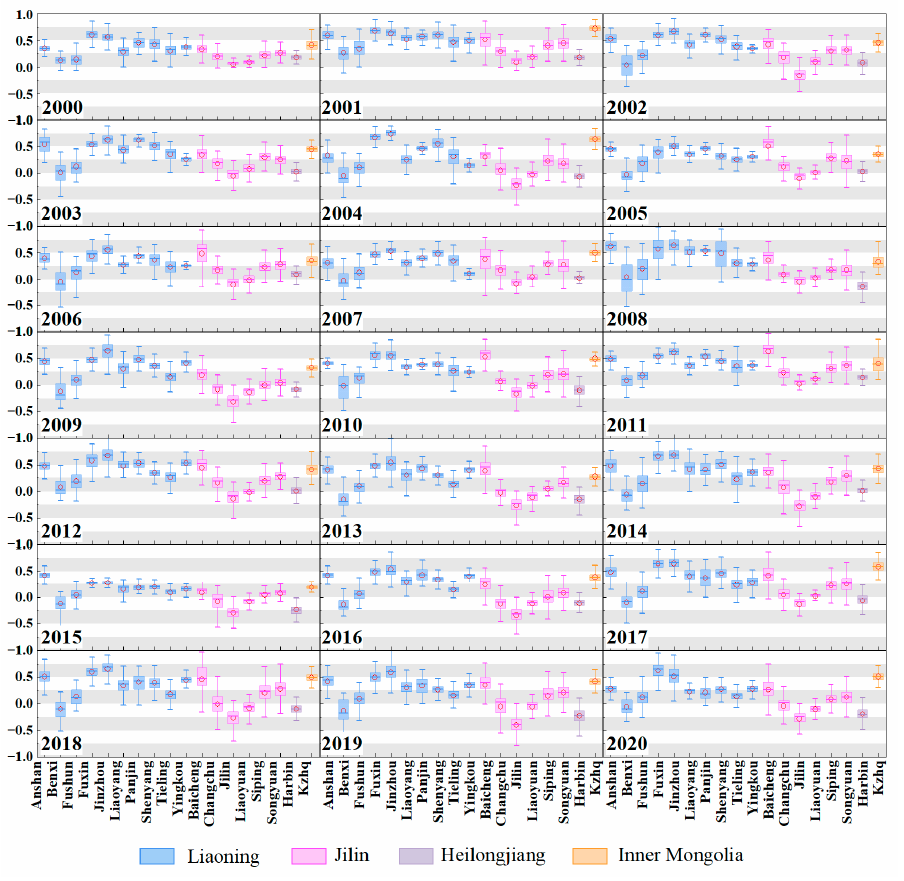
Figure 11. Box line map of drought and waterlogging hazard in maize growing area in Songliao Plain from 2000 to 2020.